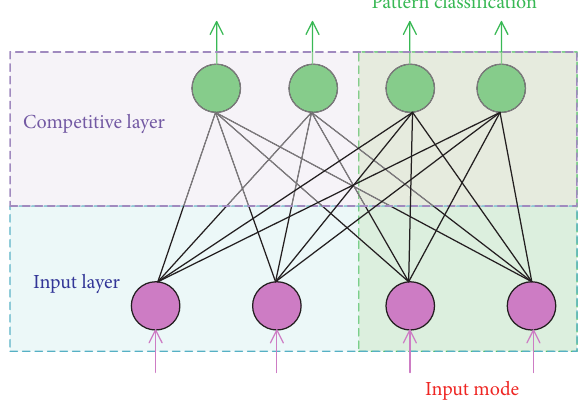
Figure 2: Network structure